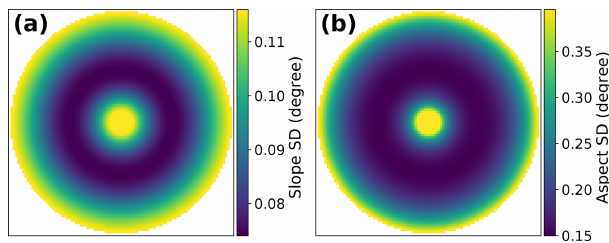
Figure 4. Gaussian hill ( n = 101) slope and aspect standard devia- tions for spatially invariant noise (SD = 1 e − 4 ), derived from eleva- tion uncertainty propagation (Eqs. 12–13). Aspect has higher stan- dard deviations than slope, as aspect varies between [0, 360) and slope only between [0, 90). This is evident especially on flat terrain (e.g., the edges of the Gaussian